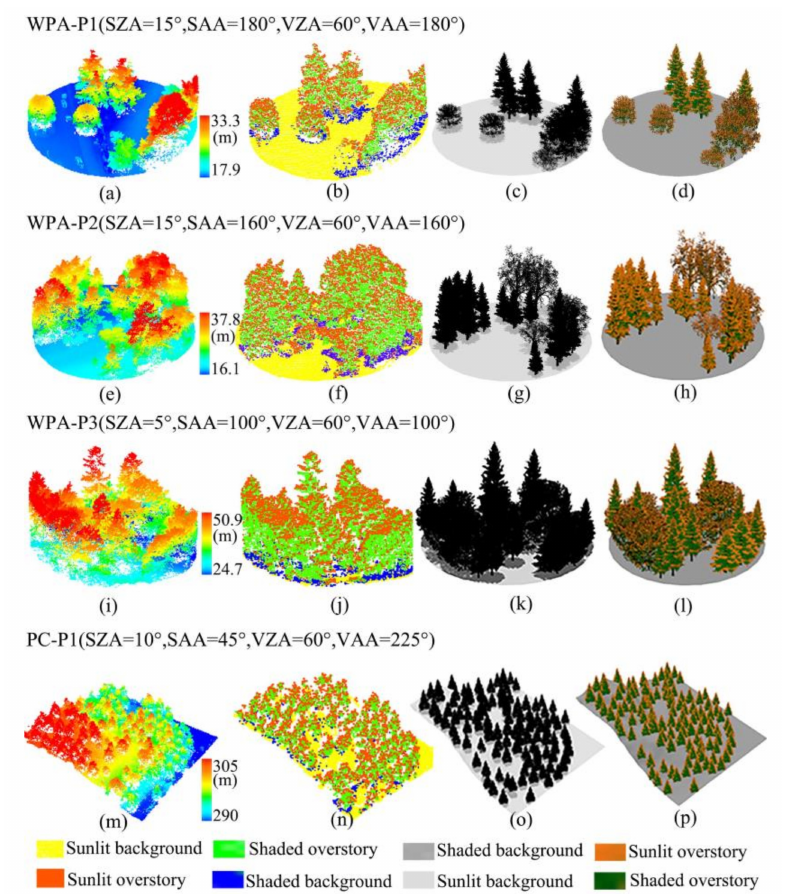
Figure 7. The original ALS data (insets a,e,i,m ) and their four forest component estimation results (insets b,f,j,n ) for four forest plots (i.e., WPA-P1, WPA-P2, WPA-P3, and PC- P1) and the simulated sunlit and shaded forest background (insets c,g,k,o ) and overstory ( d,h,l,p ) in both WPA and PC sites, respectively. SZA, SAA, VZA, and VAA represent solar zenith angle, solar azimuth angle, view zenith angle, and view azimuth angle,